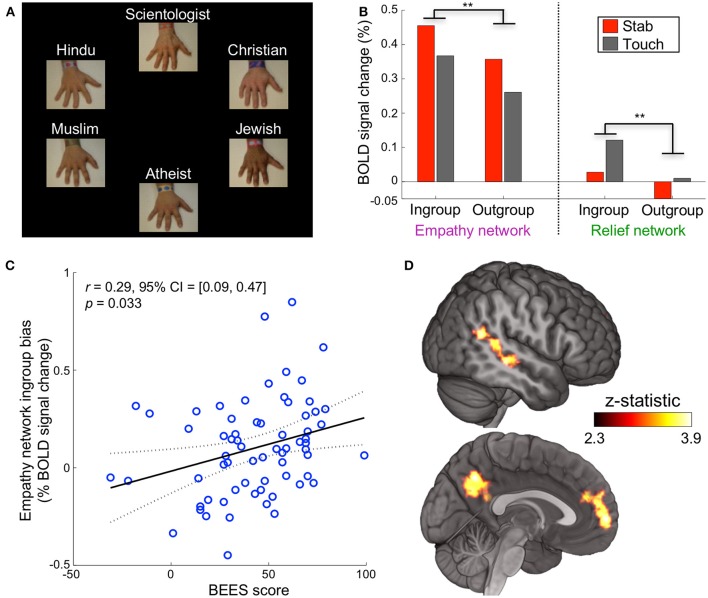
Religious labels modulate empathic neural response. (A) Experiment 1 was identical in structure and timing to the baseline block but used religious labels instead of impartial labels. (B) When a participant saw their ingroup, in comparison to their outgroup, stabbed or touched, neural activation was significantly higher in the empathy network (**p < 0.01 corrected) and relief network (**p < 0.01 corrected, repeated measures ANOVA, paired data, n = 67 participants). (C) Participant scores on the Balanced Emotional Empathy Scale (BEES) correlated with their ingroup – outgroup bias in the empathy network. (D) A whole-brain ingroup>outgroup contrast yielded three significant regions: the mPFC, PCC/precuneus, and pSTS/TPJ (p < 0.05 FWE). These areas are involved in cognitive empathy and perspective taking; we refer to them collectively as the mentalizing network. The mentalizing network right pSTS is more medial than the relief network right pSTS cluster. No significant voxels appeared in the contrast outgroup>ingroup.